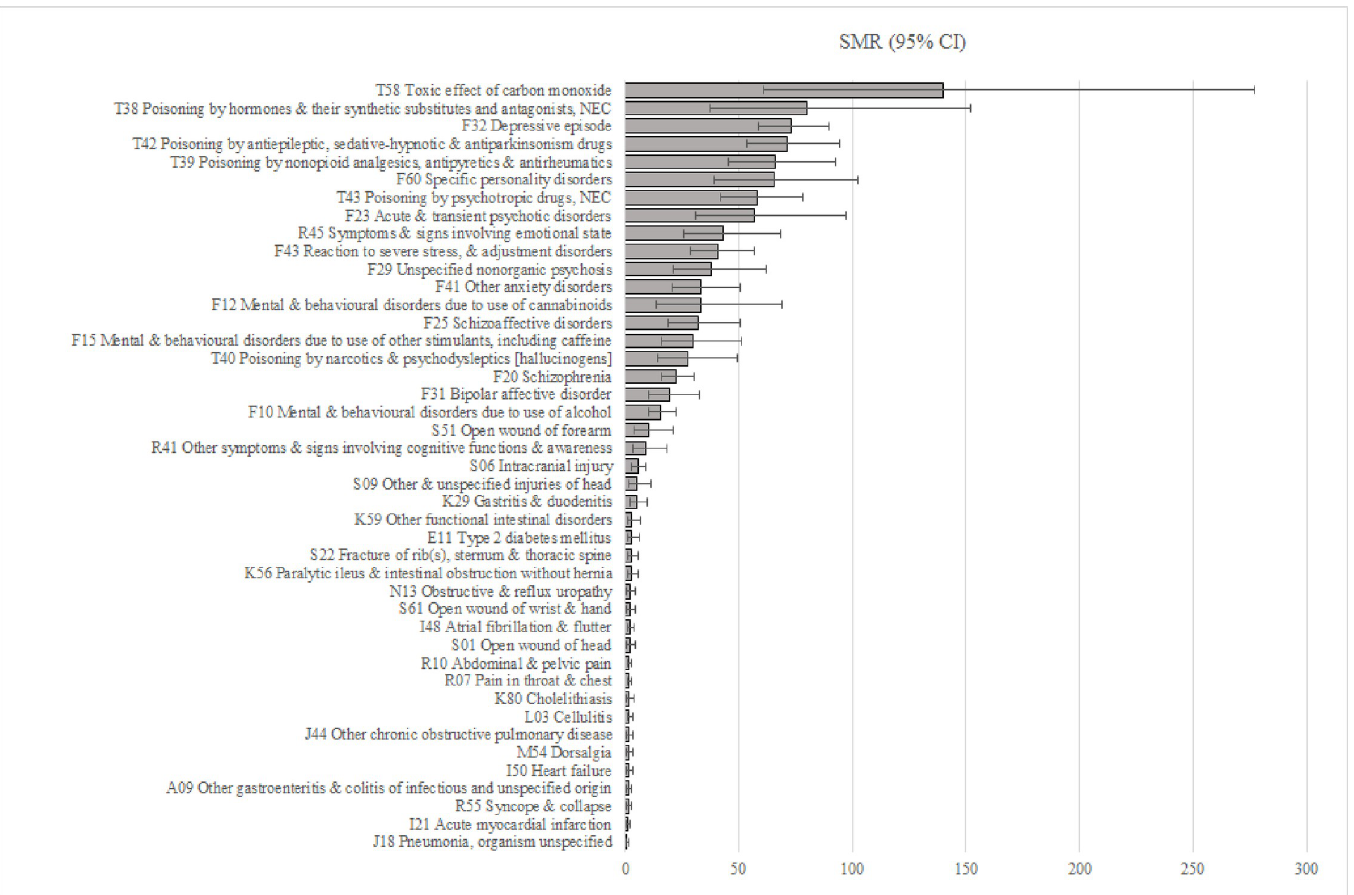
Fig 1. SMR (95% CI) for forty-three conditions associated with at least five suicides.